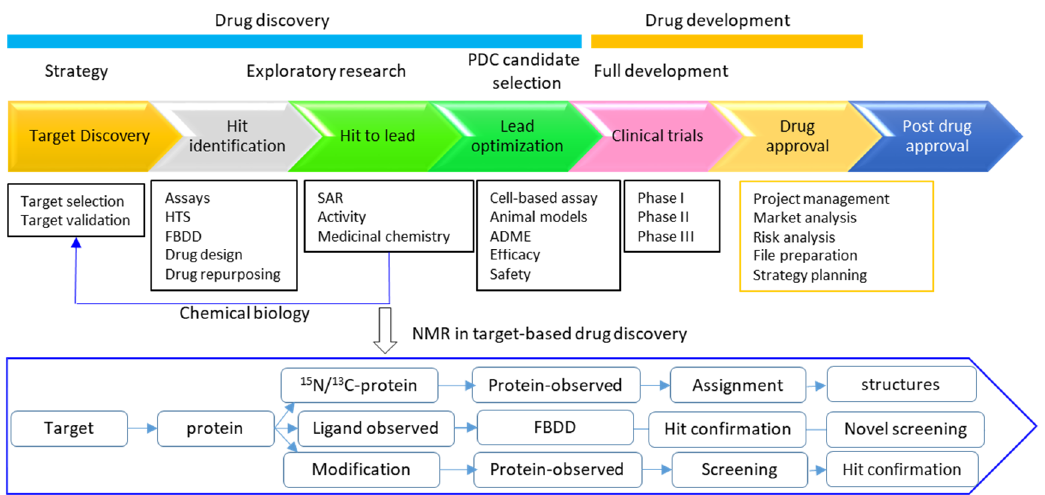
Figure 7. A simplified flowchart for drug discovery and application of NMR in target-based drug discovery. Protein-observed and ligand-observed experiments are applicable for detection of target–ligand interactions, which is dependent on the targets and the screening strategies. ADME means absorption, distribution, metabolism and excretion. SAR indicates structure activity relationship.